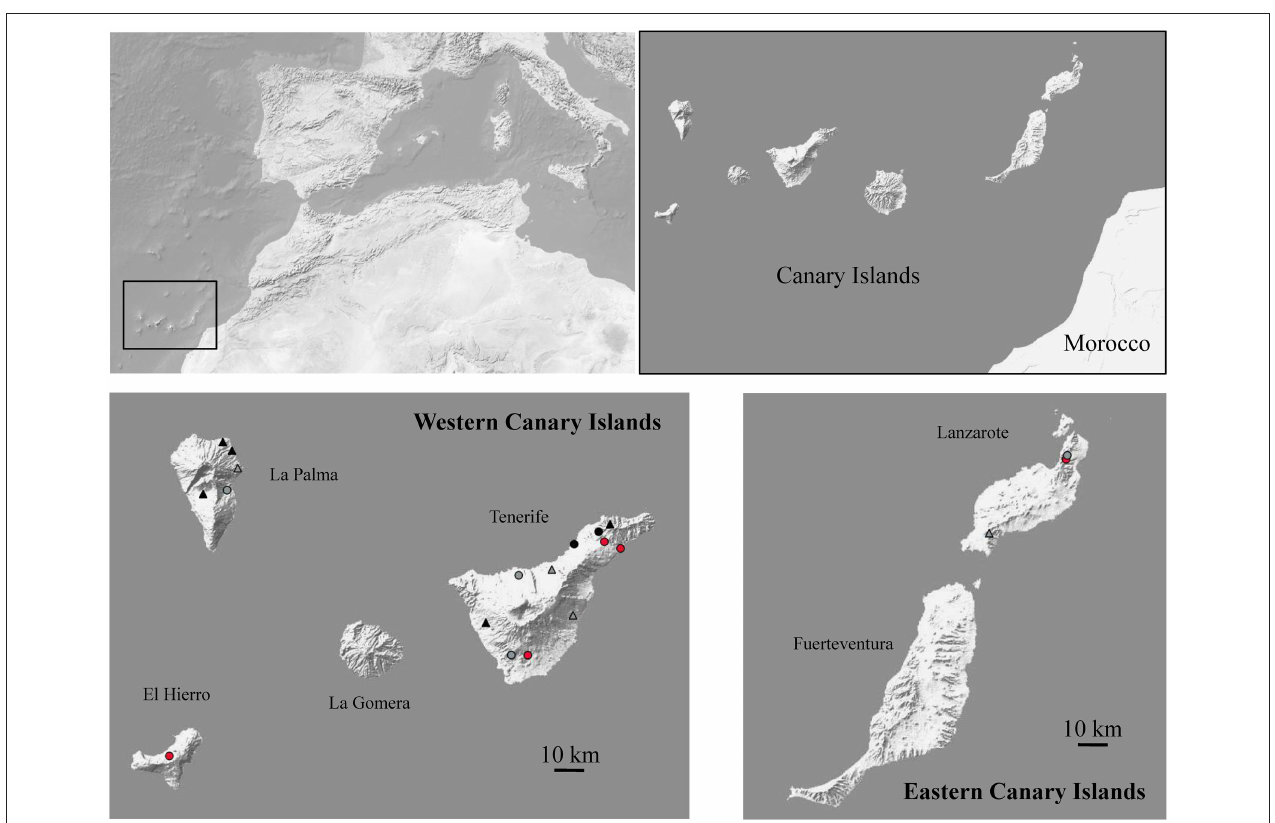
FIGURE 1 | Map of the region studied showing the 20 investigated sites and highlighting in red those where samples were found positive for coronaviruses. Black and gray indicate localities where samples were found negative for coronaviruses with presence or absence of Mus musculus , respectively. Circles and triangles indicate anthropic and no anthropic localities,